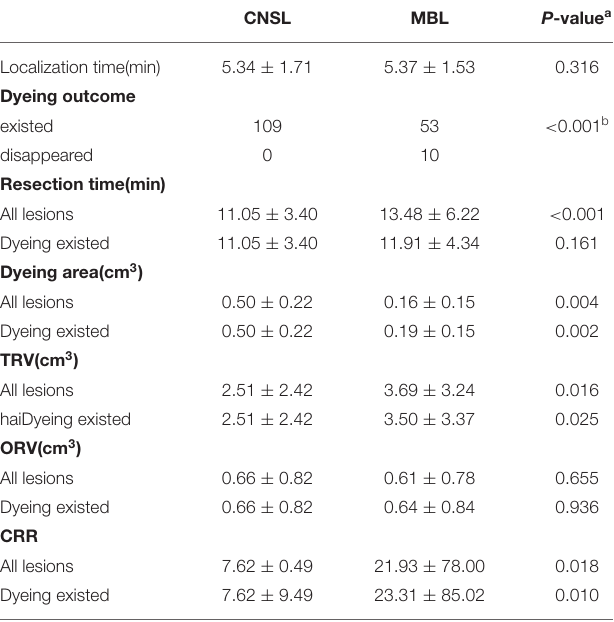
TABLE 3 | Clinical features of lesions